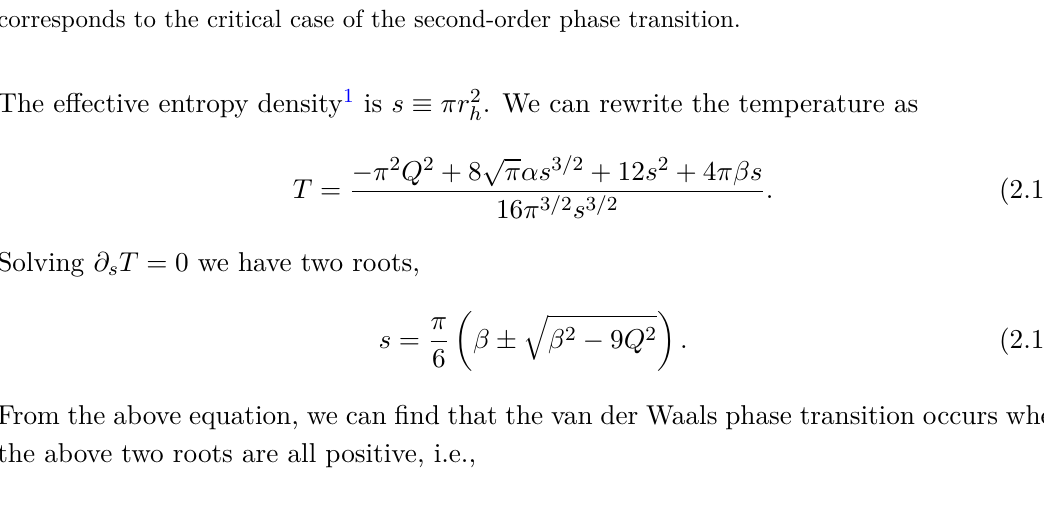
Figure 1 . The phase transition at several different values of the Q . The solid lines are the T − s relation at Q specified by the plot legends, where the lighter segments correspond to the metastable regions. The dashed horizontal lines, of which the parameters match the color of the plot legends, are the critical temperature where the phase transition occurs. The brown curve Q = 0 . 3333 corresponds to the critical case of the second-order phase